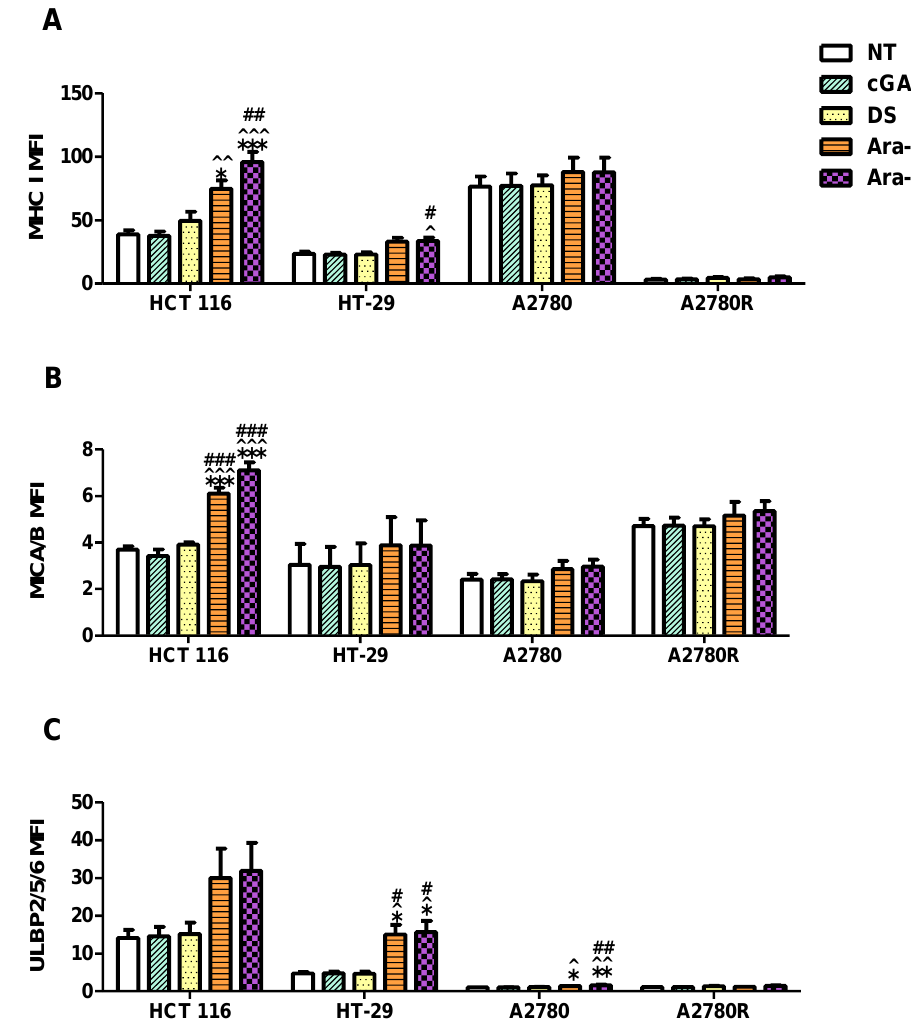
Figure 8. Comparison of the surface expression of immune ligands on HCT 116, HT-29, A2780 and A2780R. Cells were treated with Ara-C/DS, its components (50 nM Ara-C, 1 µ g/mL DS) or cGAMP (1 µ g/mL) for 48 h prior to analysis of ( A ) MHC I, ( B ) MICA/B and ( C ) ULBP2/5/6 surface expression by flow cytometry. The reported MFI was normalized to a non-stained control (data represented as the average of three independent experiments, ± SEM). Statistical analysis performed with a one-way Anova with a Tukey’s HSD for each respective cell line where *** p < 0.001, ** p < 0.01 and * p < 0.05 as compared to non-treated (NT), ˆˆˆ p < 0.001, ˆˆ p < 0.01 and ˆ p < 0.05 as compared to cGAMP, ### p < 0.001, ## p < 0.01 and # p < 0.05 as compared to DS.